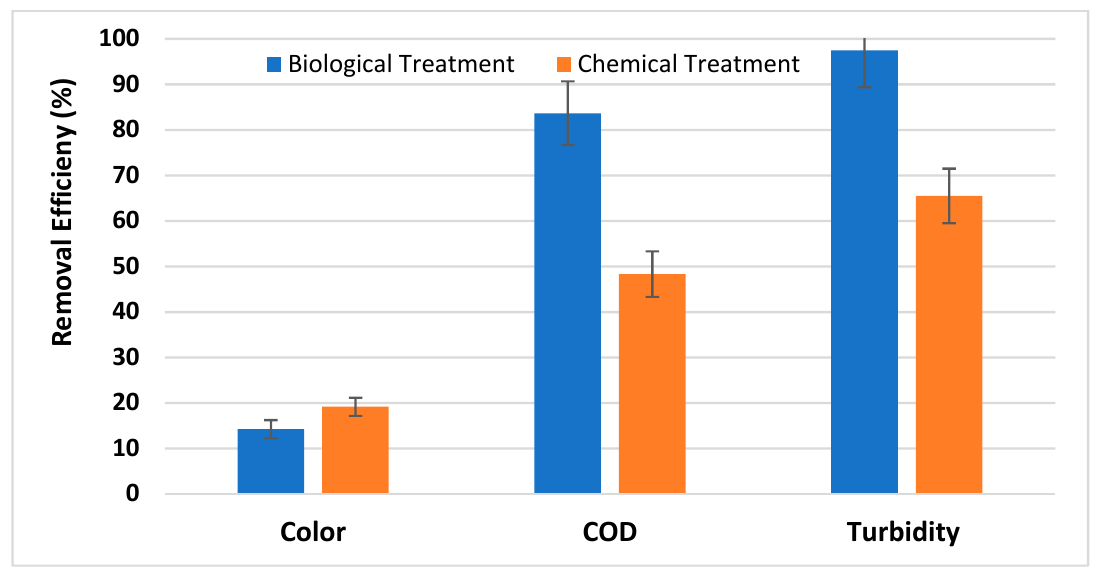
Figure 2. Removal efficiencies of biological treatment and chemical treatment of wastewater from pulp and paper industry for color, COD and turbidity. Mean values of percent removal of pollutant are presented with standard deviation.